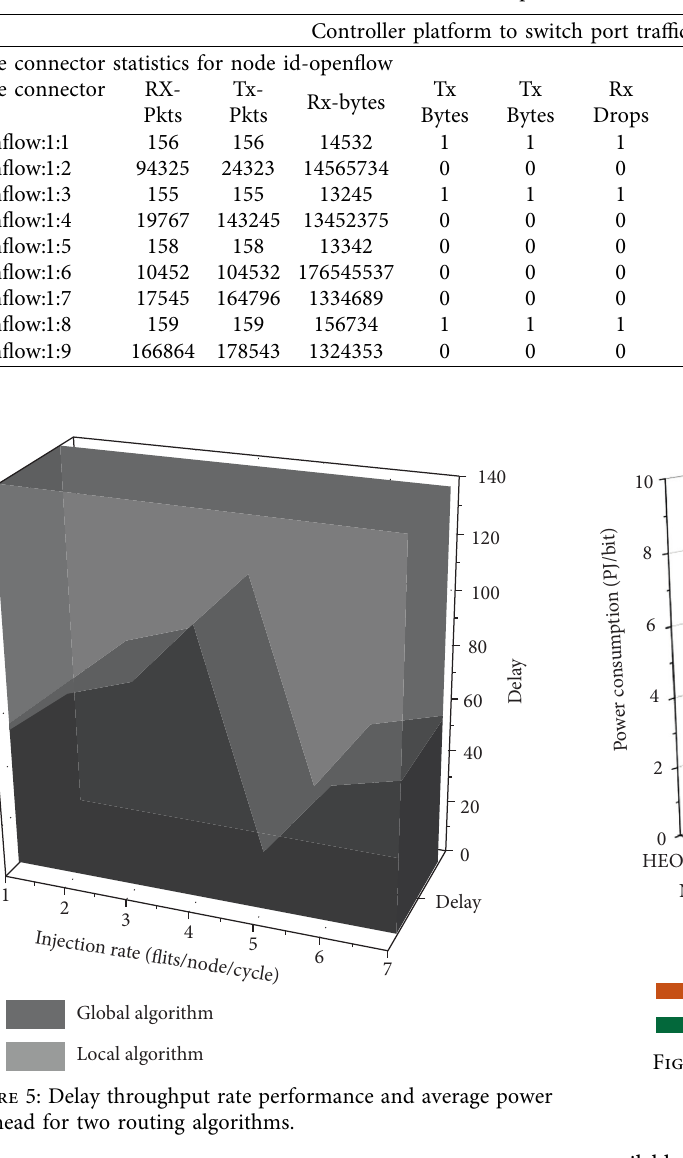
Table 1: The results of the switch port traffic statistics in the controller platform.